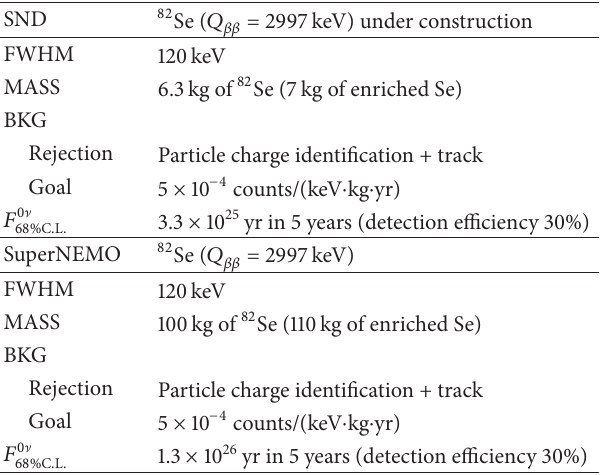
with a background counting rate as low as 0.003 counts/ (keV ⋅ kg ⋅ yr). A 𝛽𝛽 decay was identified as two electrons emitted from the 𝛽𝛽 source foil. Background sources that can mimic this kind of events are as